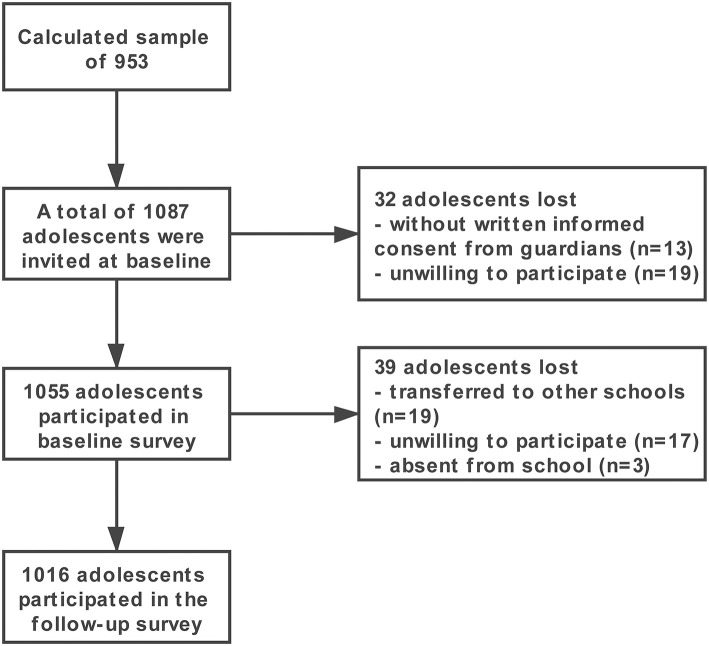
Flowchart of the survey.